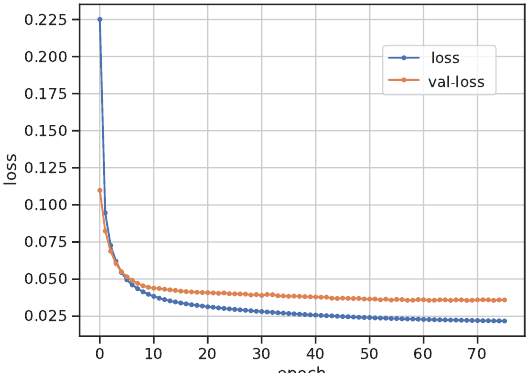
Figure 7. Comparison of the loss for 30-step-ahead